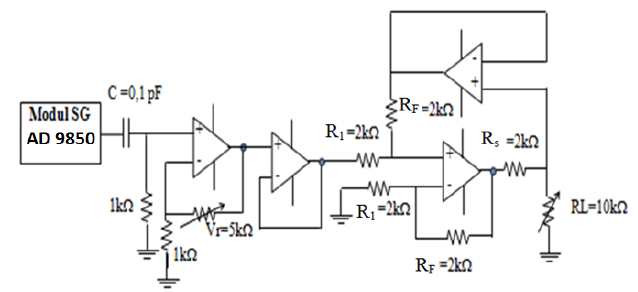
Figure 5. A signal generator and constant current.